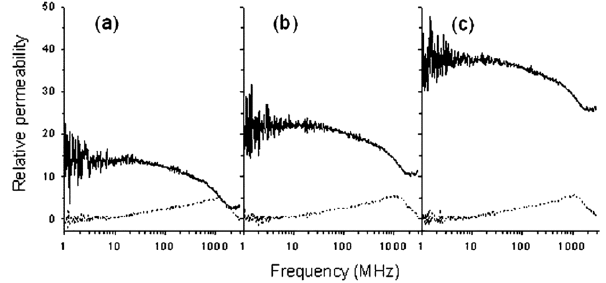
Fig. 4. CIP spectrum of Fe 78 Si 13 B 9 , measured with different sample thicknesses: (a) 27.5  m, (b) 54,9  m, (c) 110  m [5].